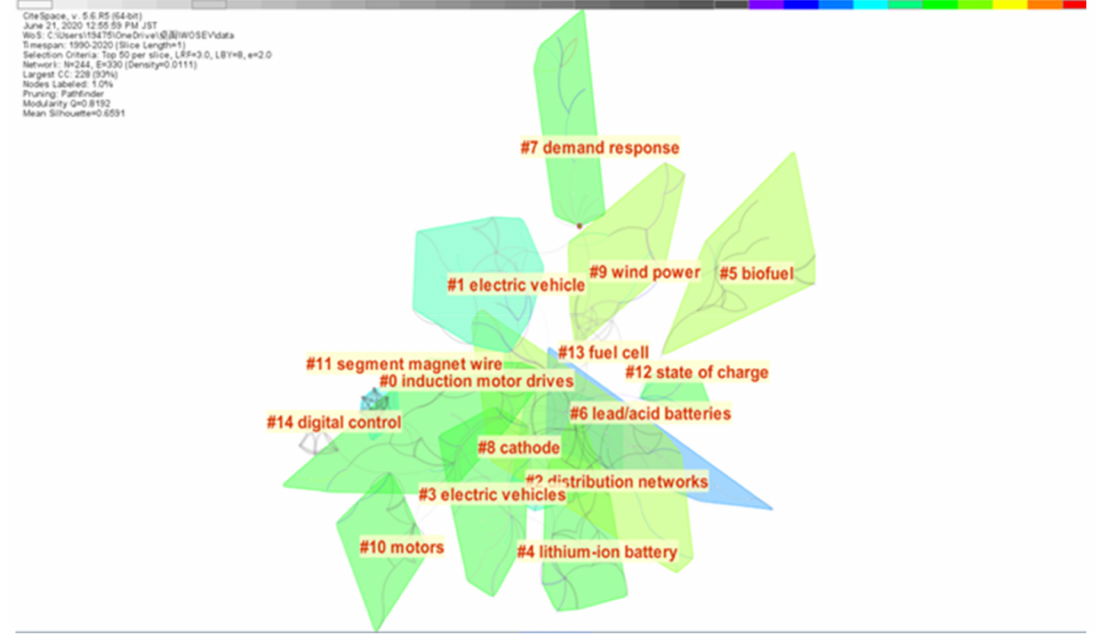
Figure 7. Popular topics of research on